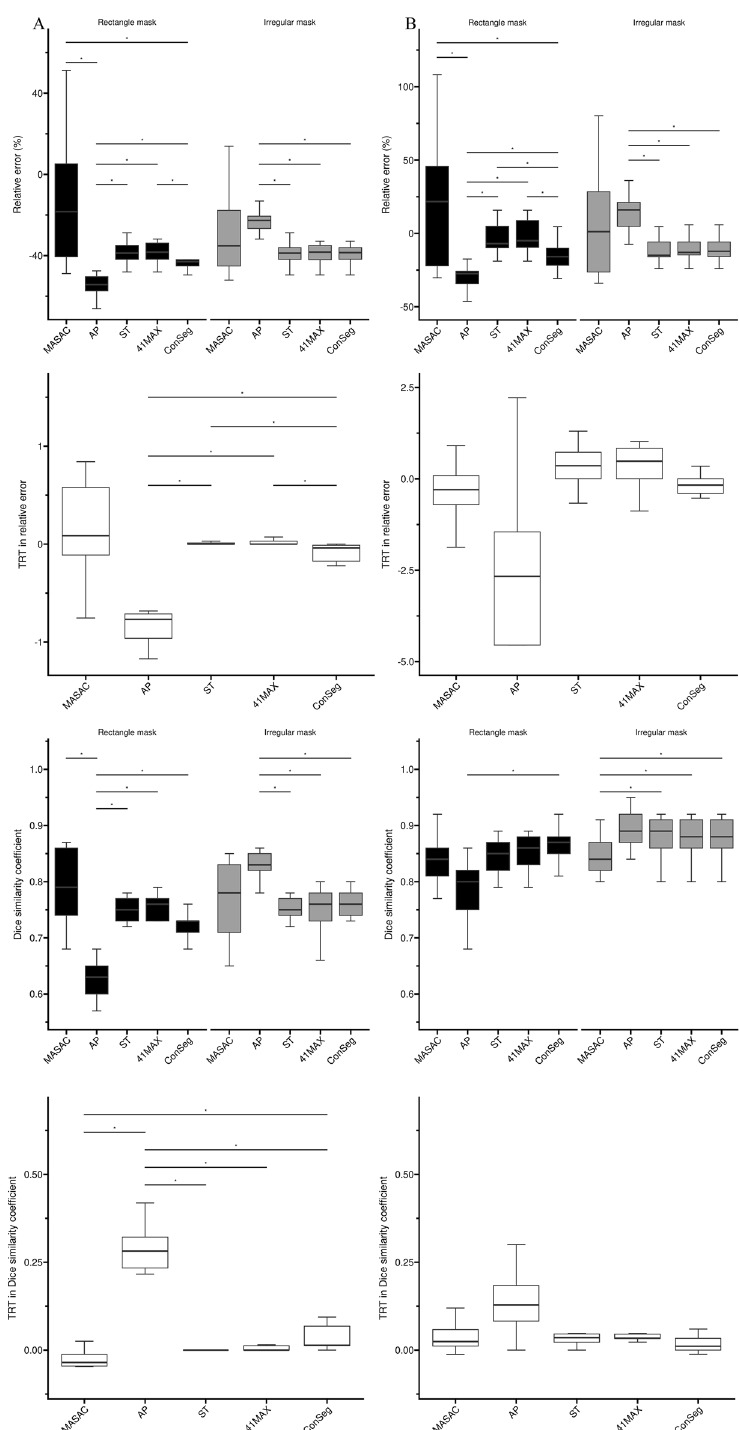
Fig. 4 Box-and-whisker plots of RE, DSC and their respective TRT metrics for each method in the anthropomorphic simulation with ( A ) and without B respiratory motion. For display purposes, outliers identified as 1.5*interquartile range were removed from plot (whiskers). Statistically significant differences are marked with horizontal